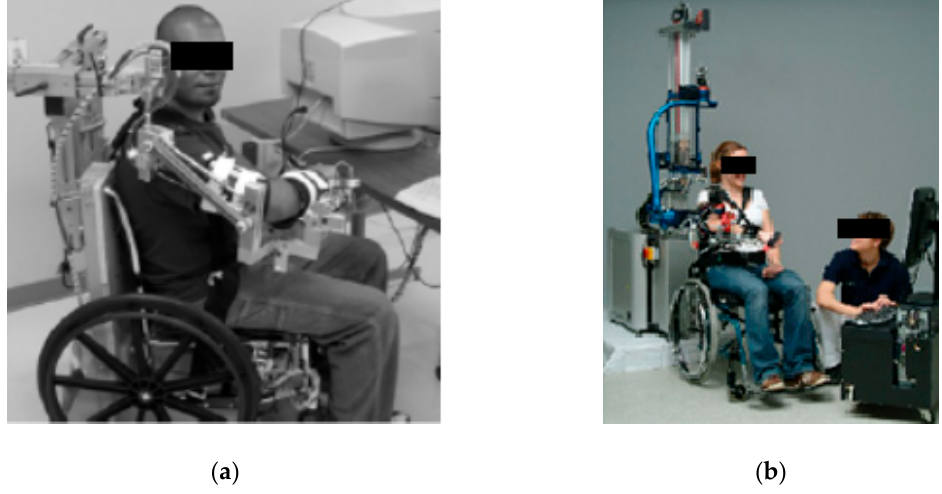
Figure 2. Examples of rehabilitation exoskeletons: ( a ) WREX [11], ( b ) Armin [5].